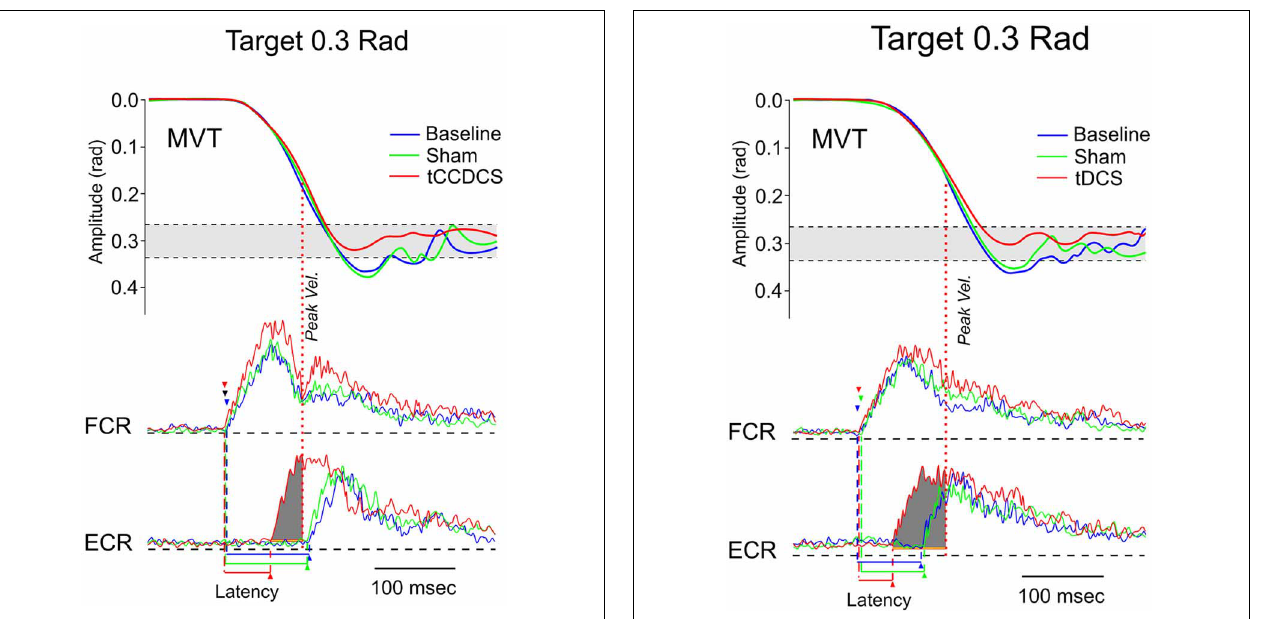
FIGURE 9 | Fast goal-directed wrist flexion movements in patient 2 (target: 0.3 rad from the start position). Top part: mean movement (MVT) in the 3 experimental conditions (blue line: basal condition, green line: sham, red line: post-tCCDCS). Middle and bottom part: FCR and ECR correspond to surface EMG activities of the flexor carpi radialis muscle and extensor carpi radialis muscle, respectively (blue lines: basal condition, green lines: sham, red lines: post-tCCDCS). Note the reduction of the onset latency of the antagonist EMG activity following tCCDCS. See also legend of Figure 8 for